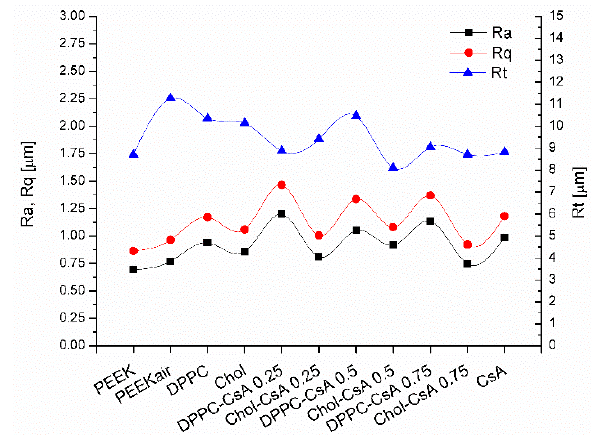
Figure 7. Roughness parameters ( R a , R q , R t ) of PEEK andmodified PEEK surfaces.